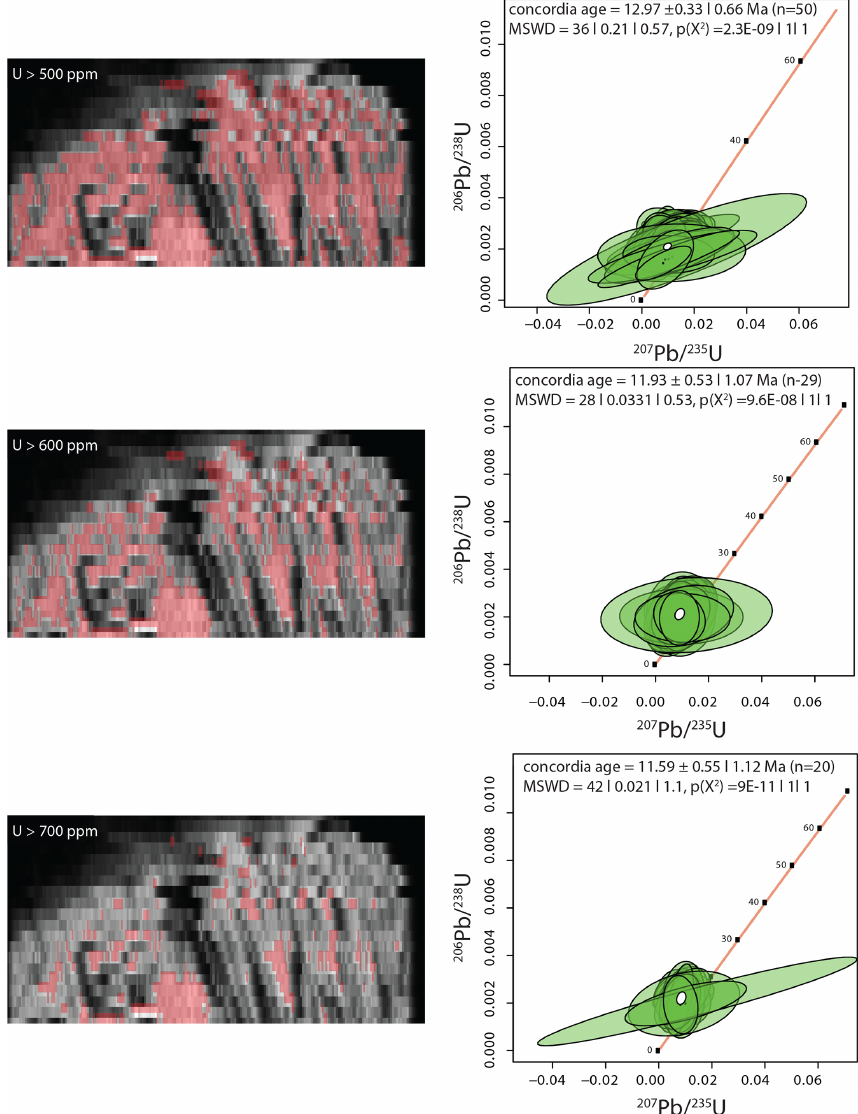
Figure 21. Map of U. Regions are selected based on U concentration as noted on the maps. Pooling pixels are based on U greater than 500, 600, and 700ppm. The data are plotted in IsoplotR (Vermeesch, 2018). No corrections for Pb are made because we do not know if there is a bias between calcite and